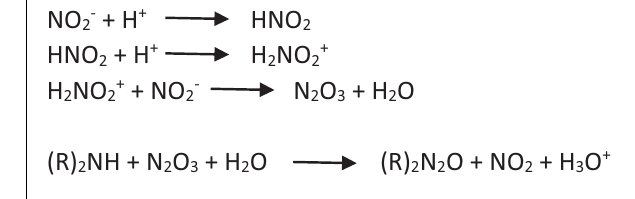
FIGURE 1 | Reduction of nitrite to nitrous anhydride, followed by nitrosation of a biogenic amine with nitrous